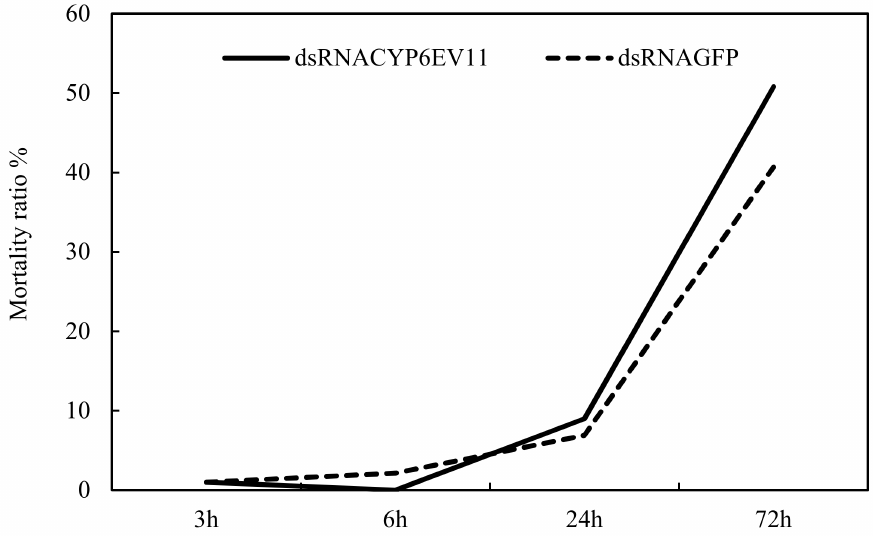
Figure 5. The mortality rate of C. kiiensis larvae with CYP6EV11 gene silencing and the groups soaked in dsGFP